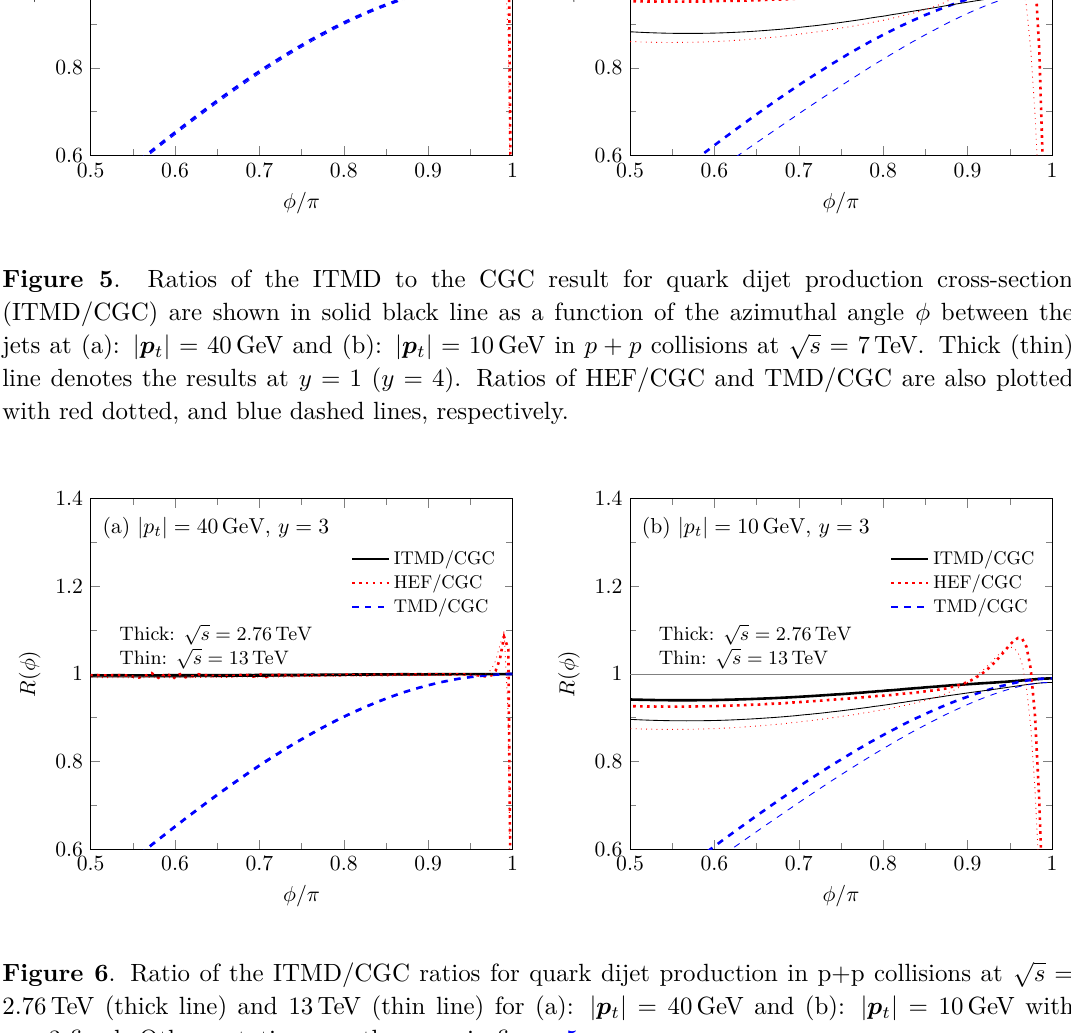
Figure 6 . Ratio of the ITMD/CGC ratios for quark dijet production in p+p collisions at 2 . 76 TeV (thick line) and 13 TeV (thin line) for (a): | p t | = 40 GeV and (b): | p t | = 10 GeV with y = 3 fixed. Other notations are the same in figure